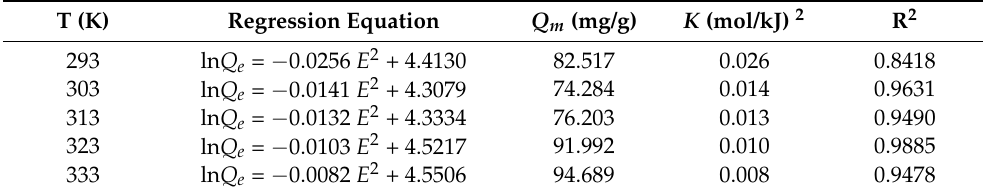
Table 7. Adsorption potential of methyl orange onto MRCM.